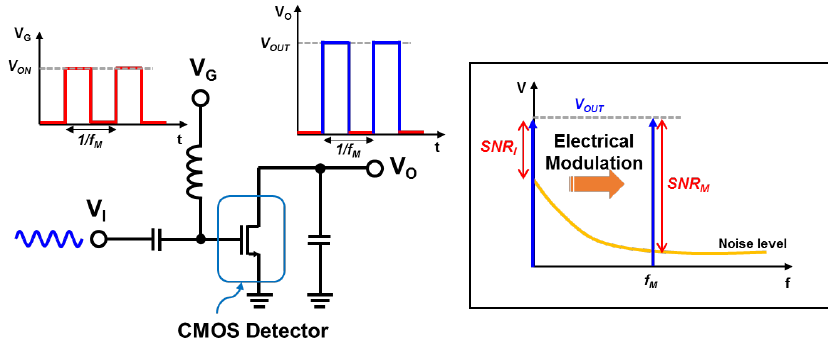
Figure 4. Schematic and conceptual diagram of electrical modulation of the detector pixel in the THz imaging system.